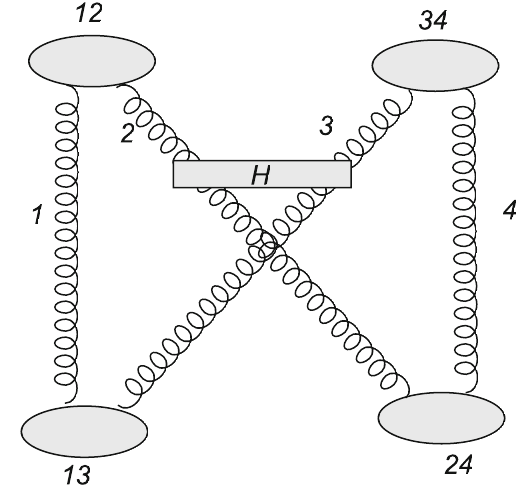
Fig. 5 Infrared stable contribution from the interaction between reggeons @ and 3. The second diagram should be added with the inter- action of reggeons 1 and 4